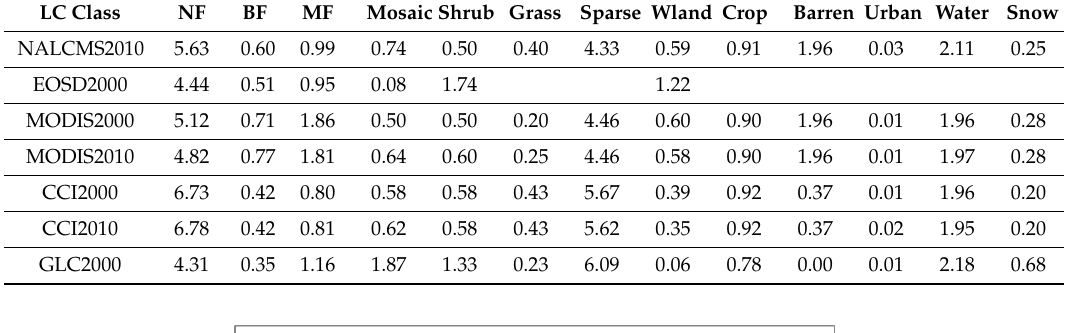
Figure 3. Maps of land cover under the common legend. The 13 classes are: 1-NF, 2-BF, 3-MF, 4- Mosaic, 5-Shrub, 6-Grass, 7-Sparse, 8-Wland, 9-Crop, 10-Barren, 11-Urban, 12-Water, 13-Snow (see Table 3 for details). Figure 4. Pixel counts for each land cover class under the common legend across Canada. Please note that the EOSD dataset is only for forested areas.